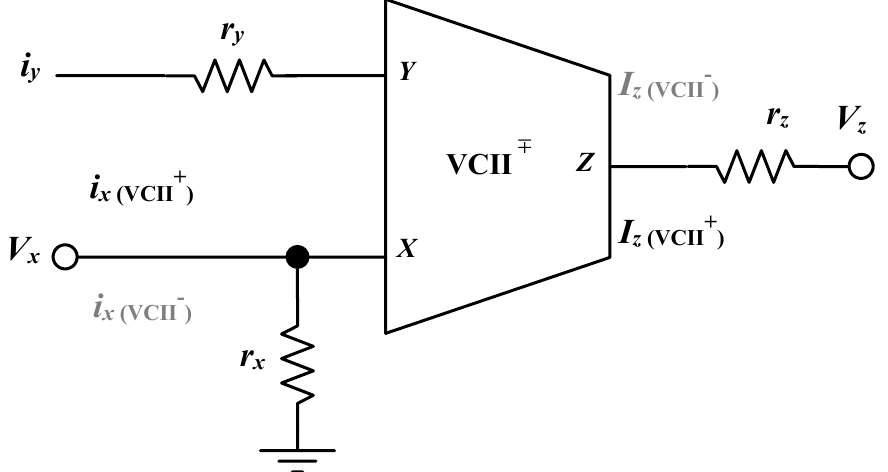
Figure 1. Block representation of the second-generation voltage conveyor (VCII) with its parasitic port impedances.